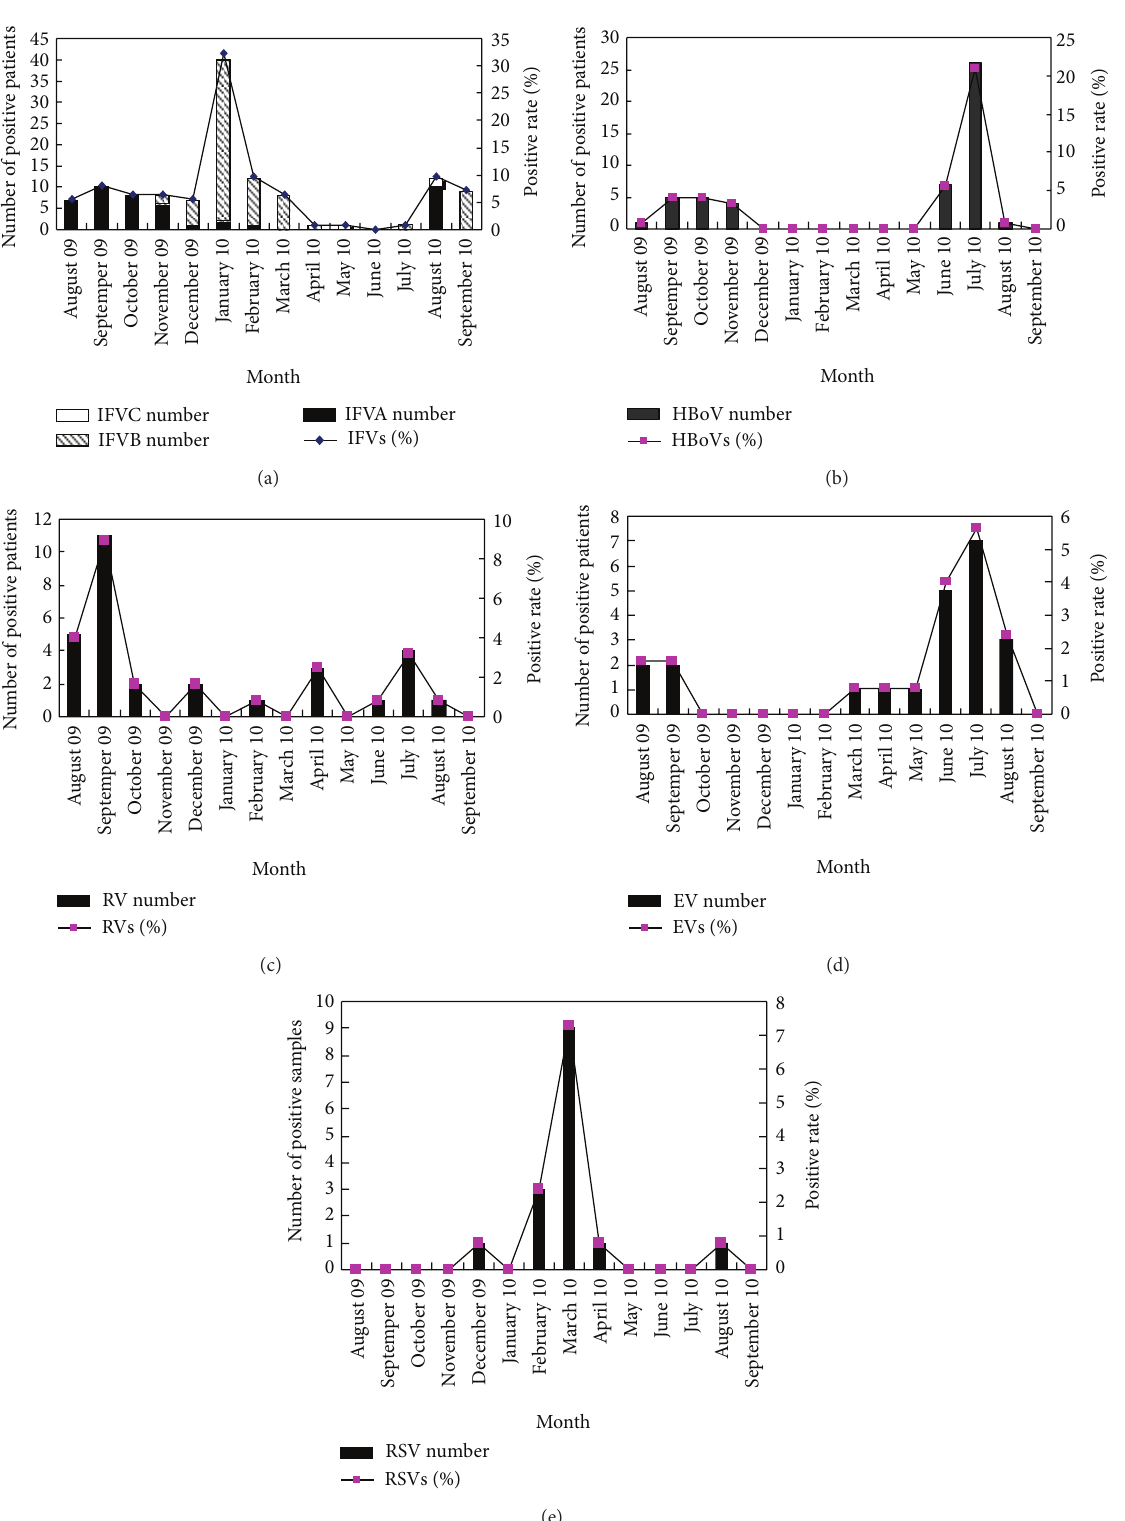
Figure 2: Number of positive patients infected with respiratory virus and the detection rate for each month. (a) IFV. (b) HBoV. (c) RV. (d) EV. (e)